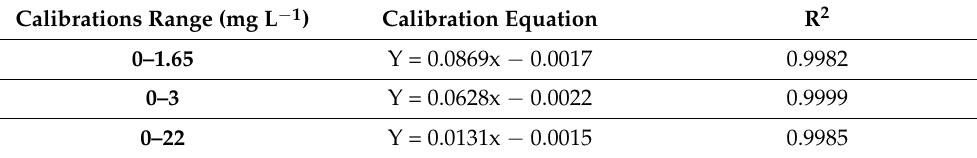
Table 2. Calibration equation, correlation coefficient of Cu (II) analyses by SAAF.